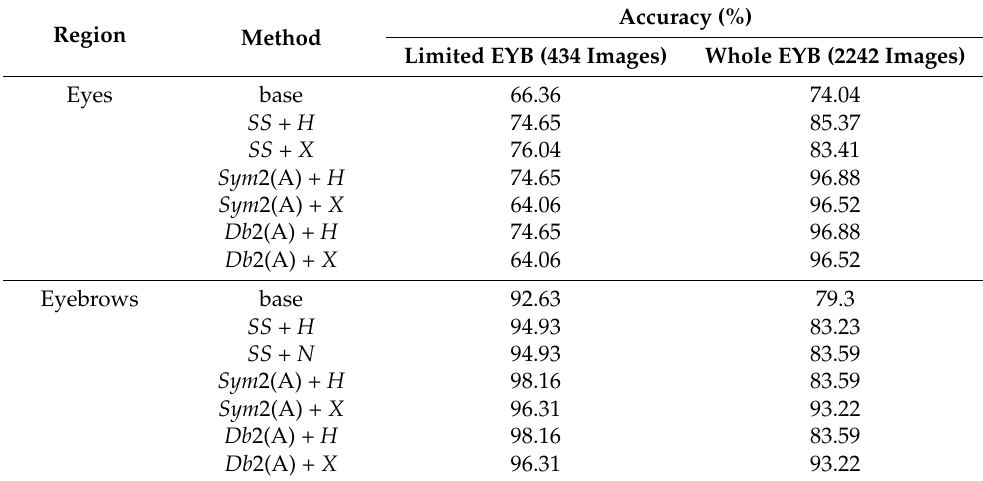
Table 11. The accuracy (%) results of the limited EYB dataset vs. the whole EYB dataset against the best method in all proposed